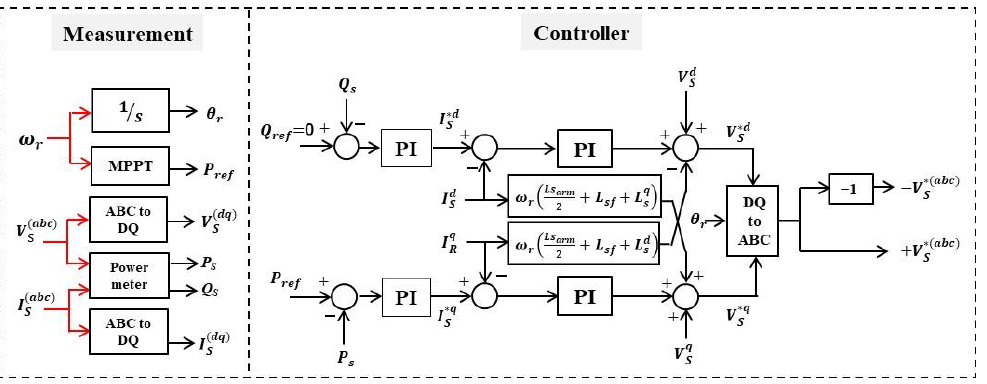
Figure 8. Stator-Side MMC